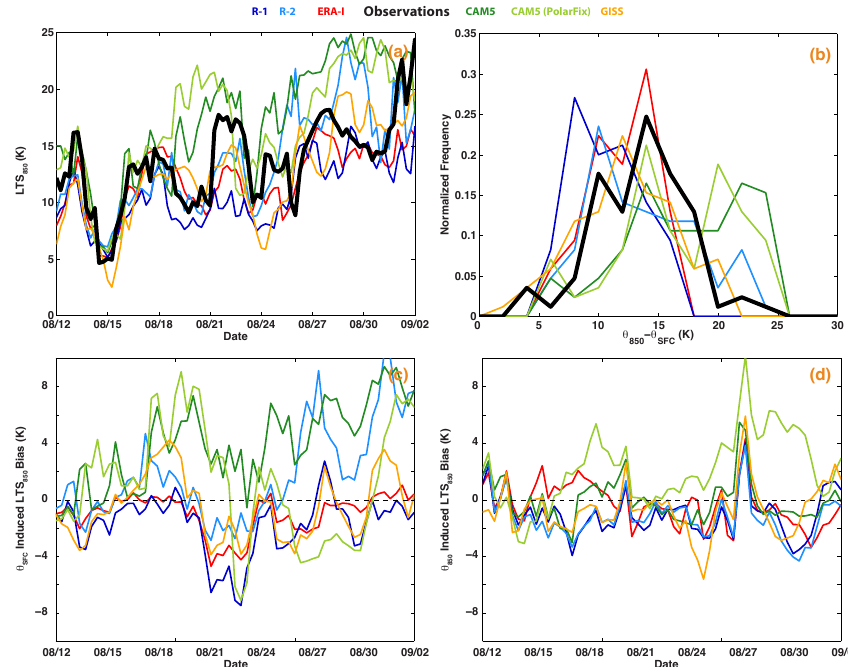
Fig. 10. Time series (a) and histograms (b) of lower tropospheric stability (LTS 850 ), as defined by the potential temperature difference between 850 mb and the surface. The lower panels (c, d) illustrate the relative contributions of near-surface potential temperature and the potential temperature at 850mb to biases in LTS 850